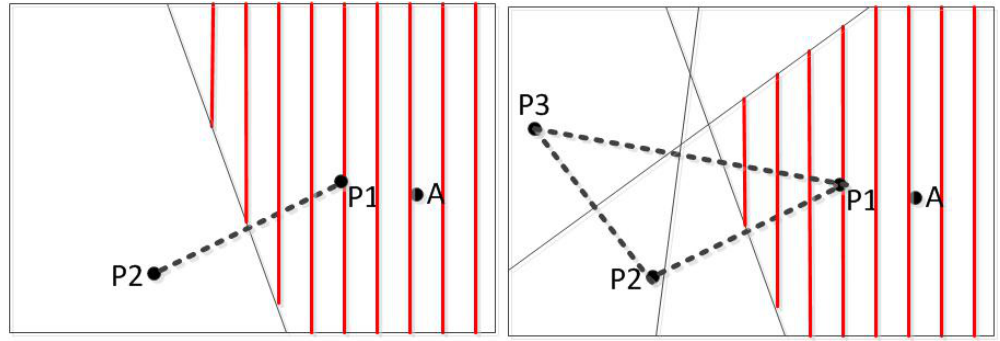
Figure 1. Schematic diagram of possible area segmentation.